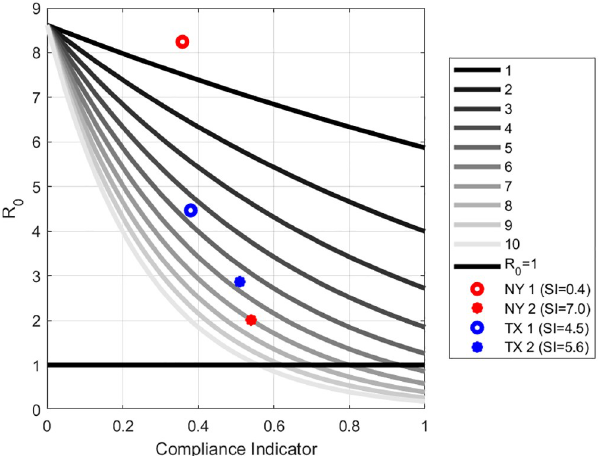
Fig 5. The combination of Stringency and Compliance needed at various levels of R 0 . Legend : This simulation tool shows the various combinations of policy measures and degrees of public compliance that will be sufficient to bring R 0 < 1 thus bringing the pandemic under control. R 0 is indicated by the bold black line which divides the graph into the “undesirable” portion (above) and the “desirable” portion (below). We have simulated where New York and Texas were for two different periods as they moved closer to the desirable